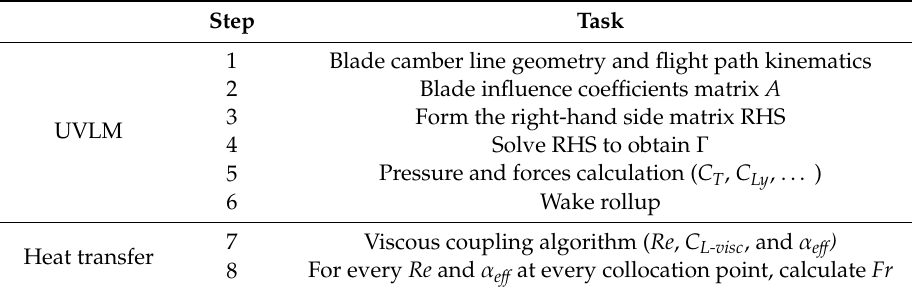
Table 2. Unsteady vortex lattice method (UVLM)-RHT solution procedure.